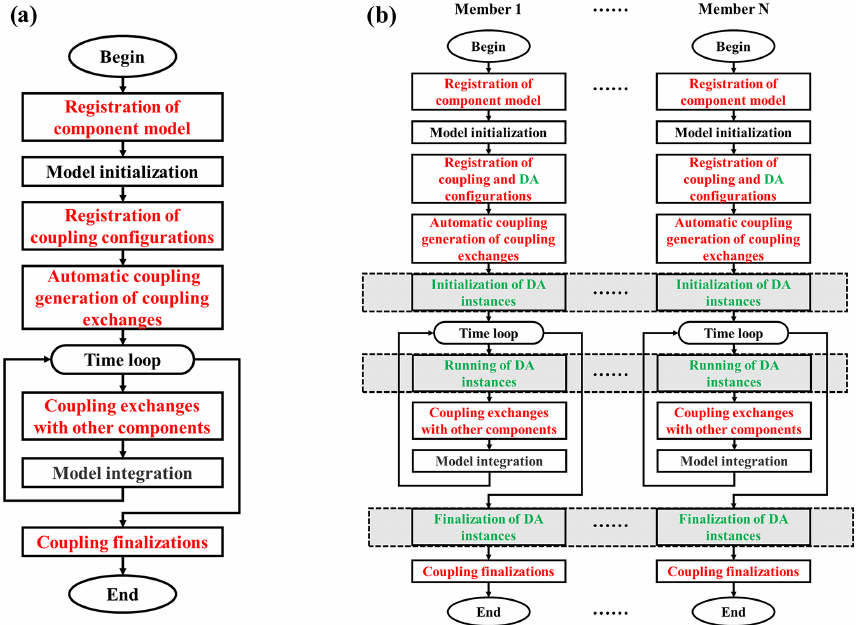
Figure 1. Model flow chart with C-Coupler2.0 (a) and a new model flow chart with ensemble DA based on C-Coupler2.0 (b) . Black font indicates the major steps in the original flow chart of a component model without coupling, red font indicates the major steps for achieving coupling exchanges among component models with C-Coupler2.0, and green font indicates the new steps for achieving coupling exchanges between a DA algorithm and a model ensemble. The gray shadow in a dashed rectangle indicates that all members in a model ensemble cooperatively work together for the corresponding step.